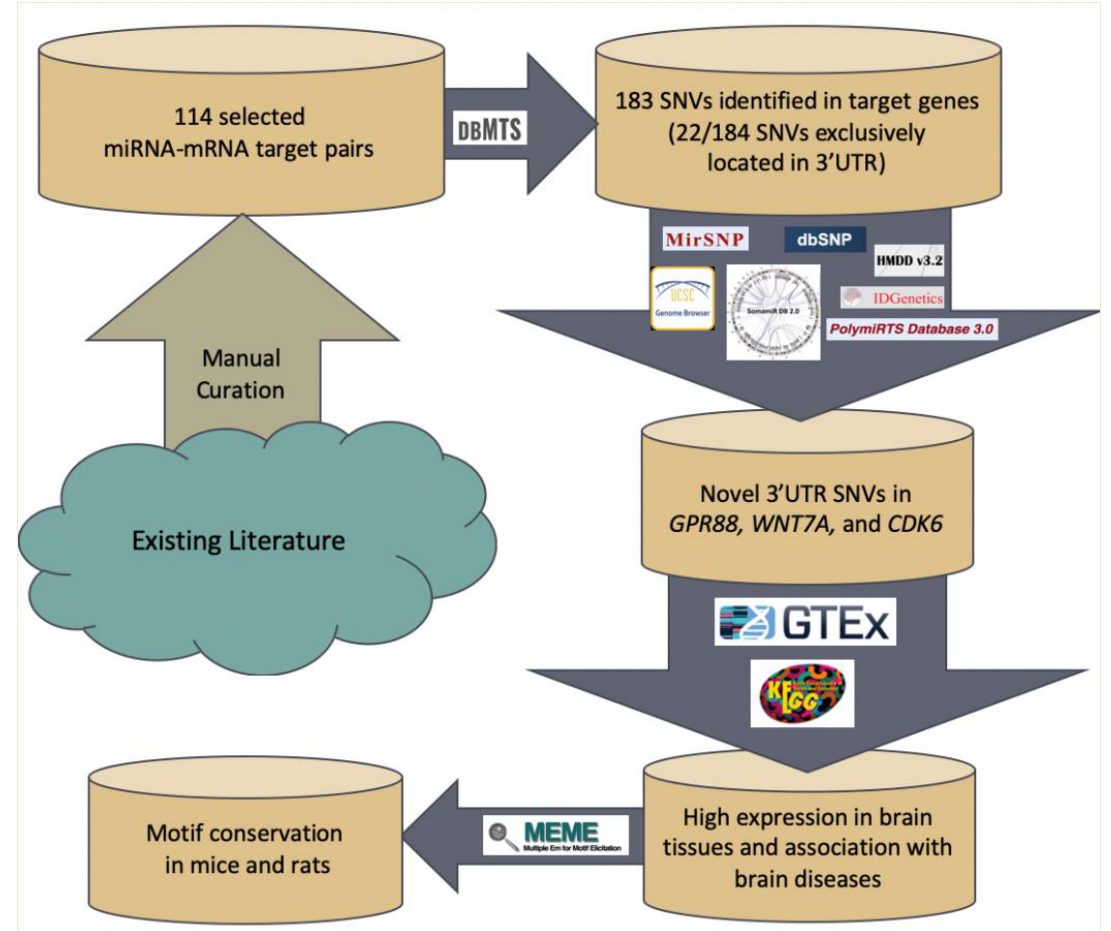
Figure 1. Work flow of prioritizing 3 (cid:48) UTR variants associated with intellectual disability